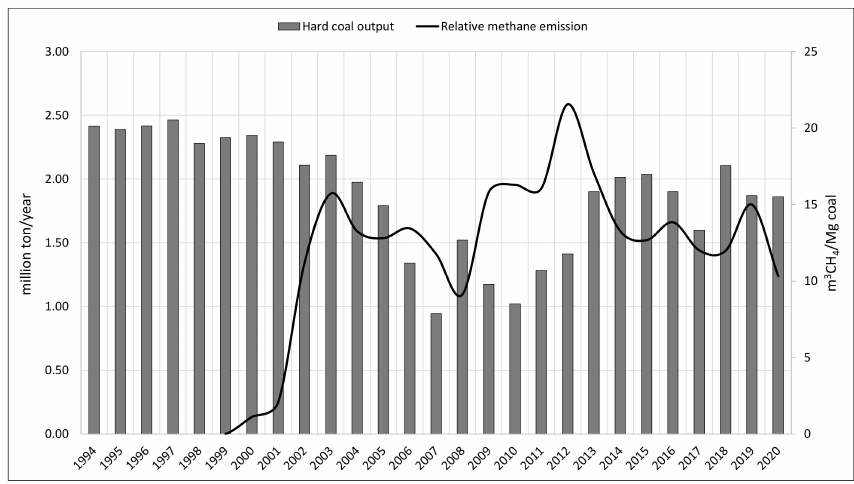
Figure 8. Hard coal output and specific methane emissions from 1994–2020 in the Rydułtowy mine.